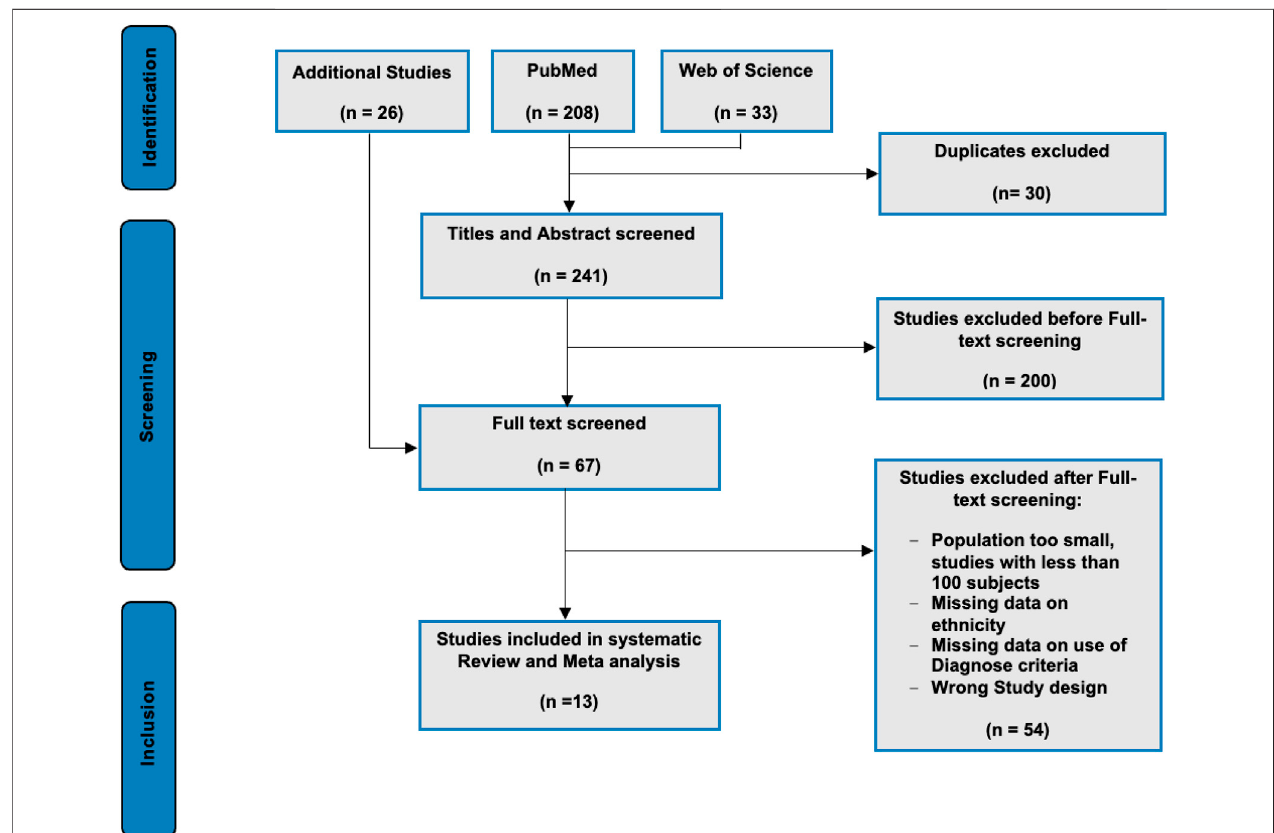
FIGURE 1 | PRISMA fl owchart of the inclusion of studies for the review and